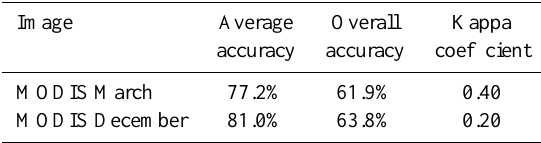
Table 5. Classification report of MODIS